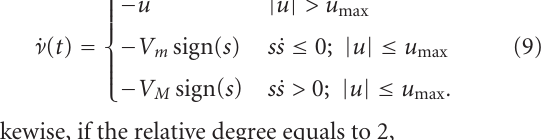
Figure 3: The convergence trajectory of twisting